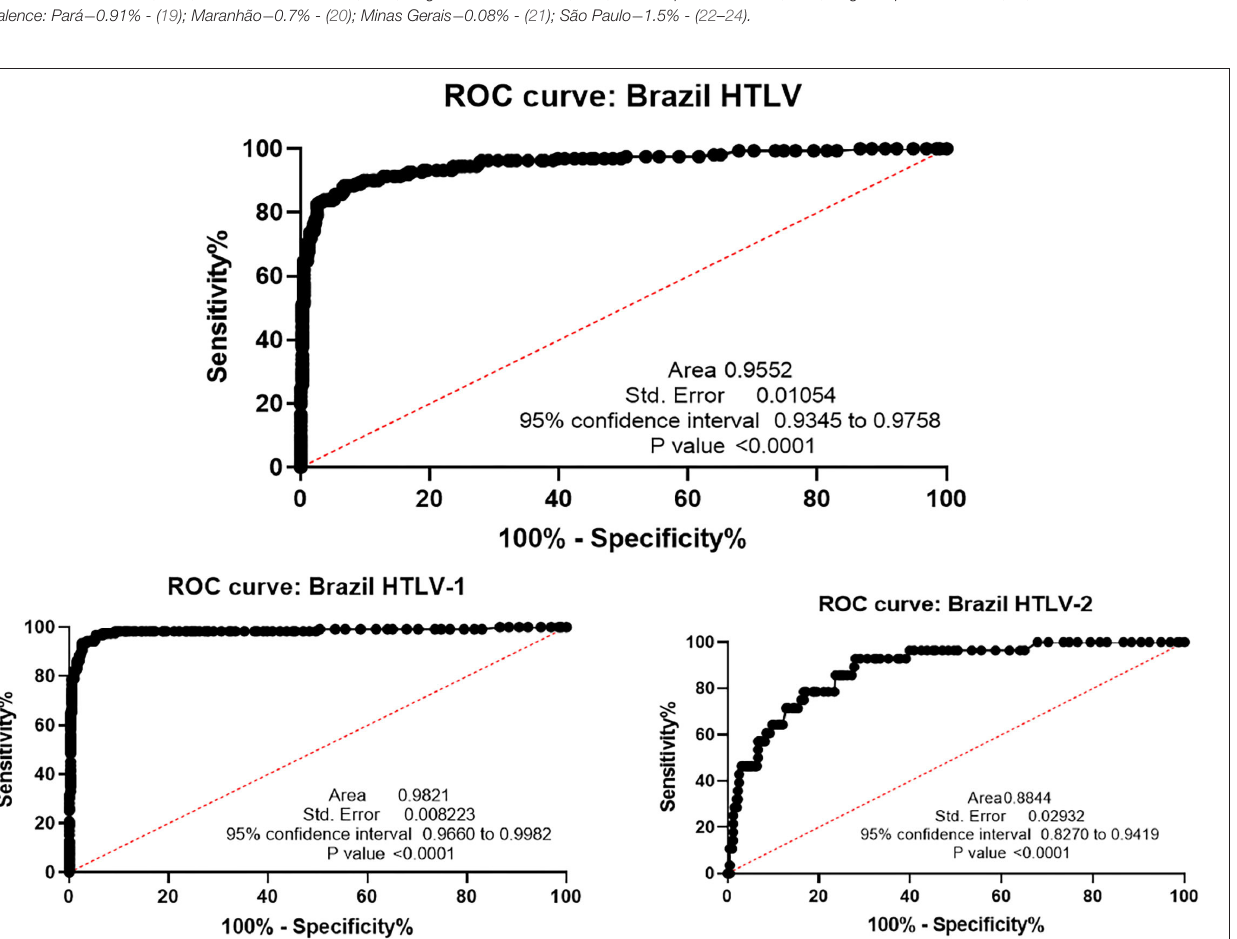
Frontiers in Public Health |